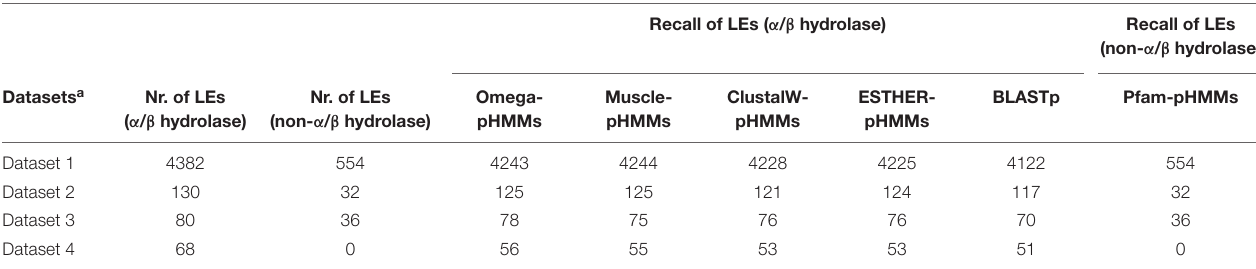
TABLE 2 | Comparison of profile HMM databases based on different alignment tools to detect LEs.